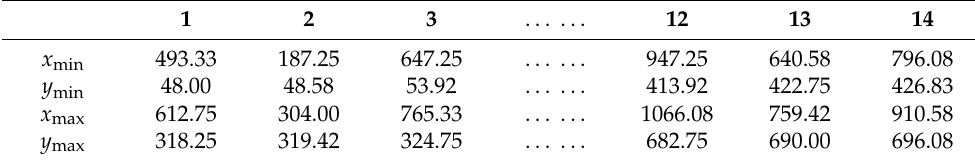
Table 3. Position of each vehicle after sorting using the TimSort